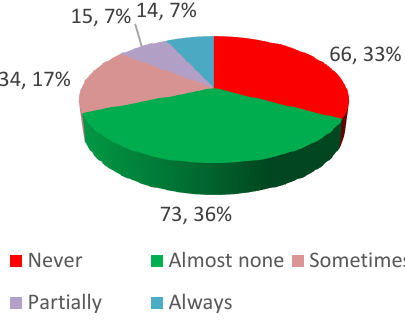
Figure 3. Problem with falling